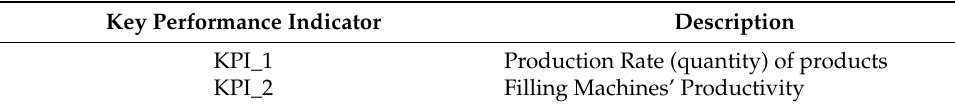
Table 9. Key Performance Indicators’ Selection. Key Performance Indicator